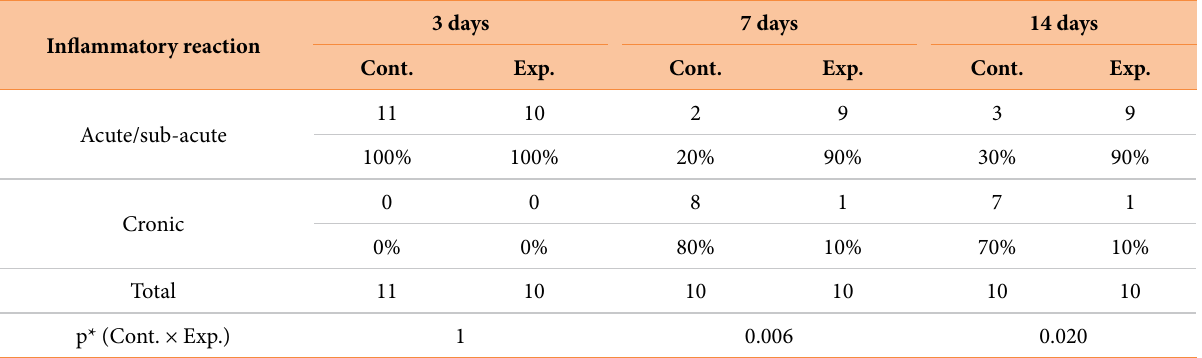
Table 1 - Inflammatory reaction quality.